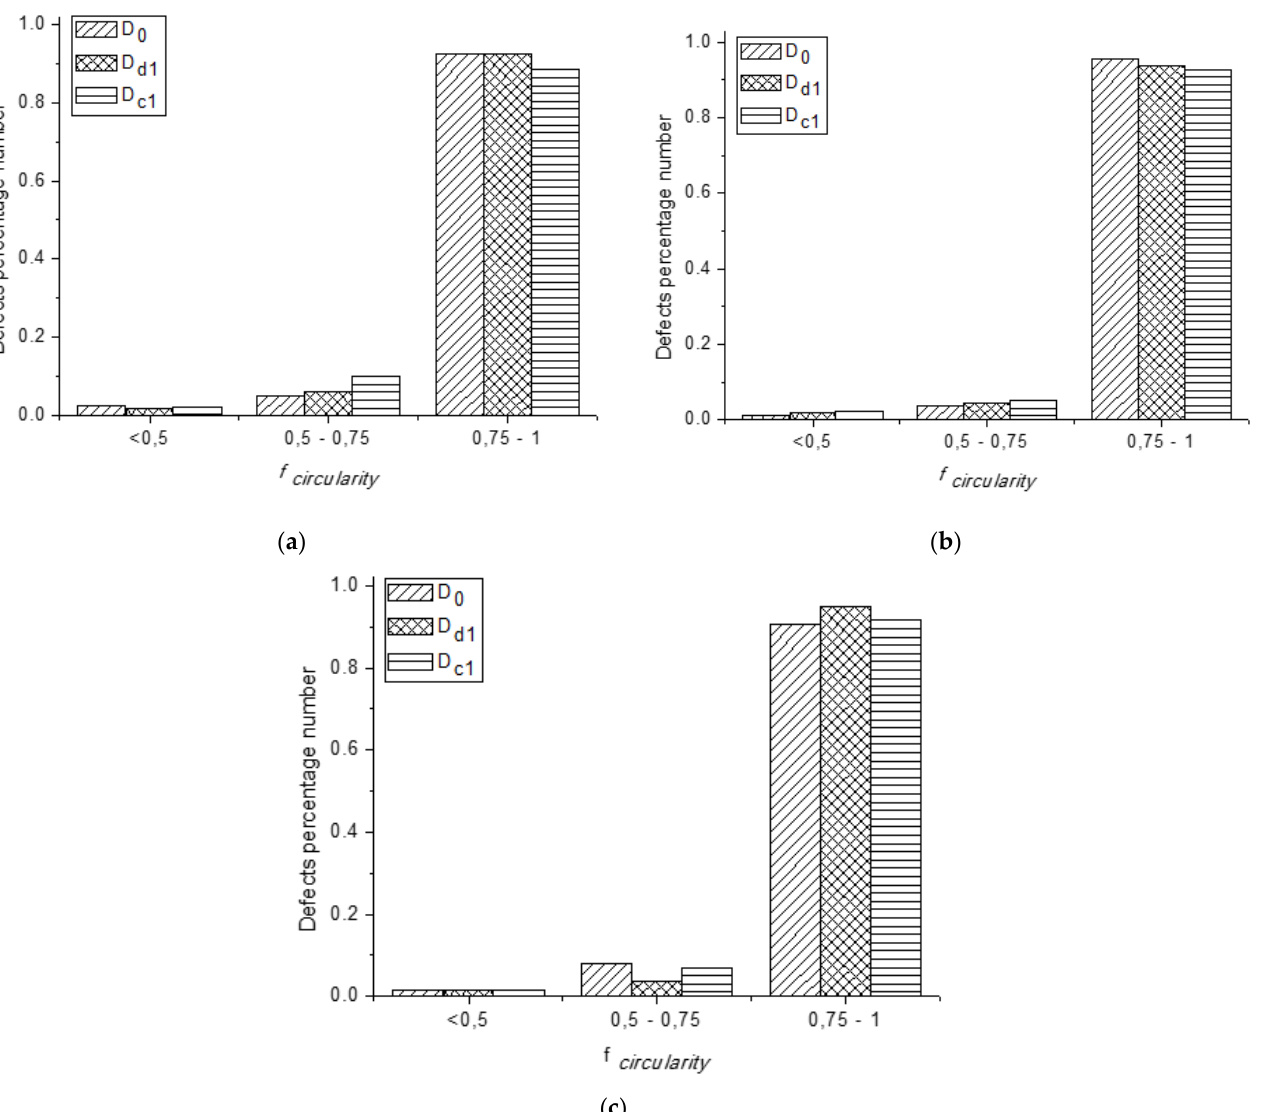
Figure 9. Distribution of the defect numbers based on the shape factors of the D 0 , D d1 , and D c1 specimens in the following sections: ( a ) T, ( b ) L1, and ( c ) L2. Table 4. Average hardness values (HV 1